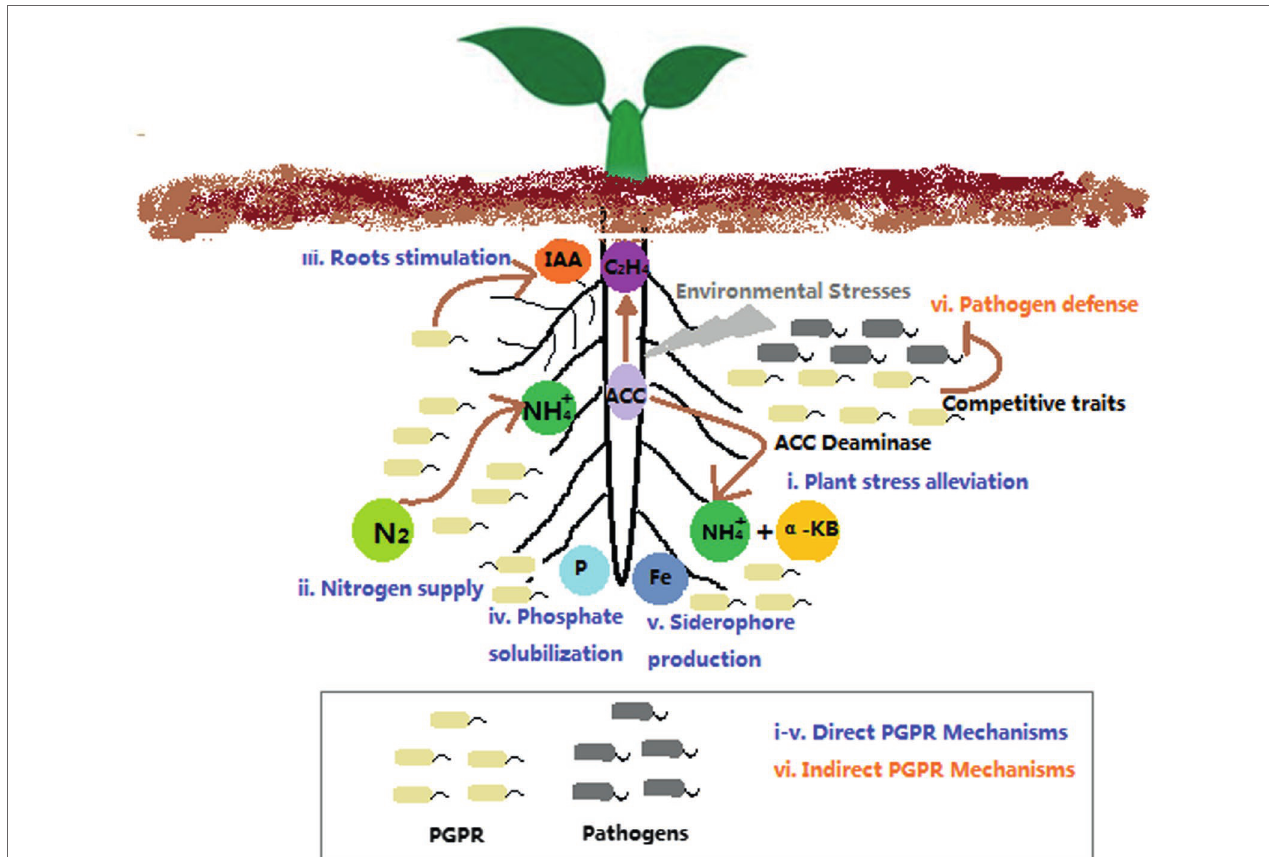
FIGURE 1 | The mechanisms of PGPR improving plant growth and